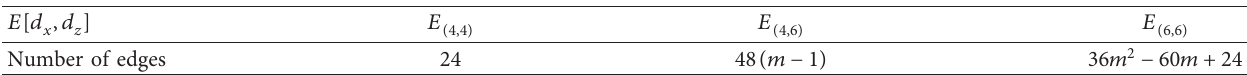
) and its strong double graph ( SD ( H 1 Table 1: Separation of